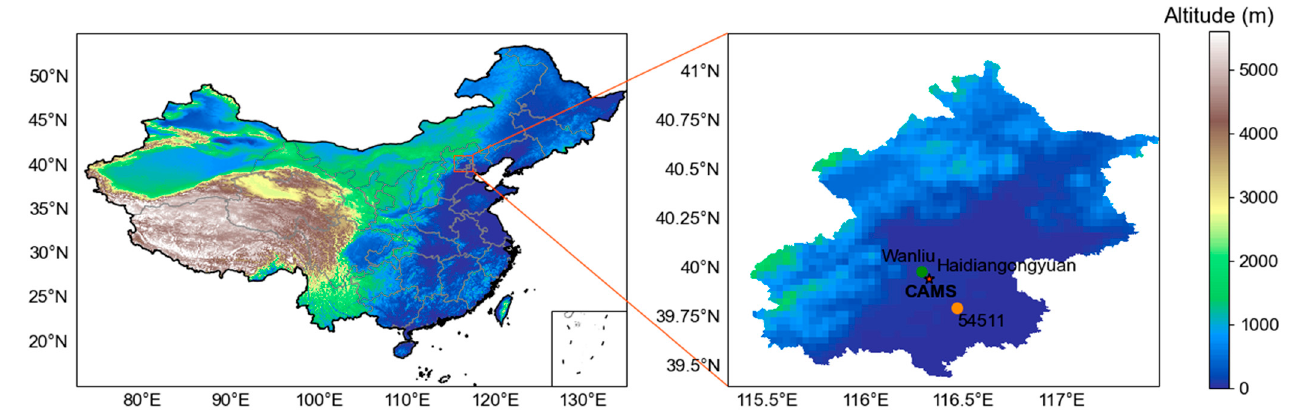
Figure 1. Location of the meteorological stations in Beijing. Red star, CAMS; orange dot, Beijing South Suburban Observatory (54511); and green dot, Haidian Park (54399) and Wanliu Station.